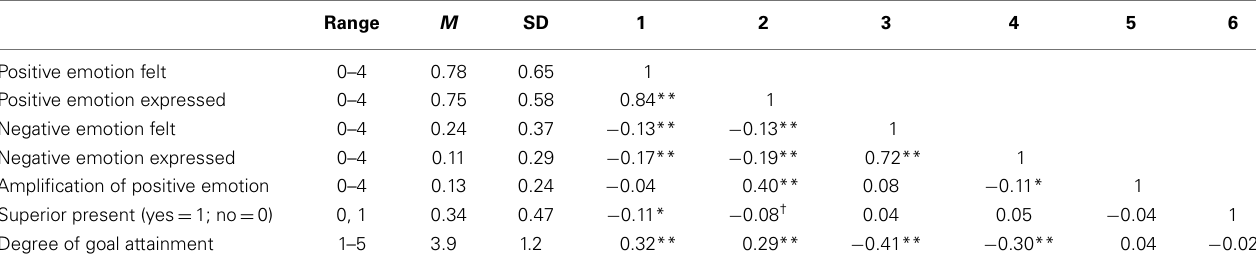
Table 2 | Means, standard deviations, and correlations between level 1